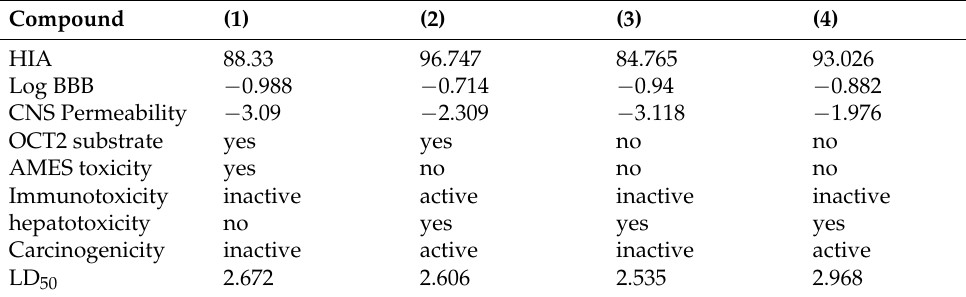
Table 5. Computational pharmacokinetics and toxicity profiles for